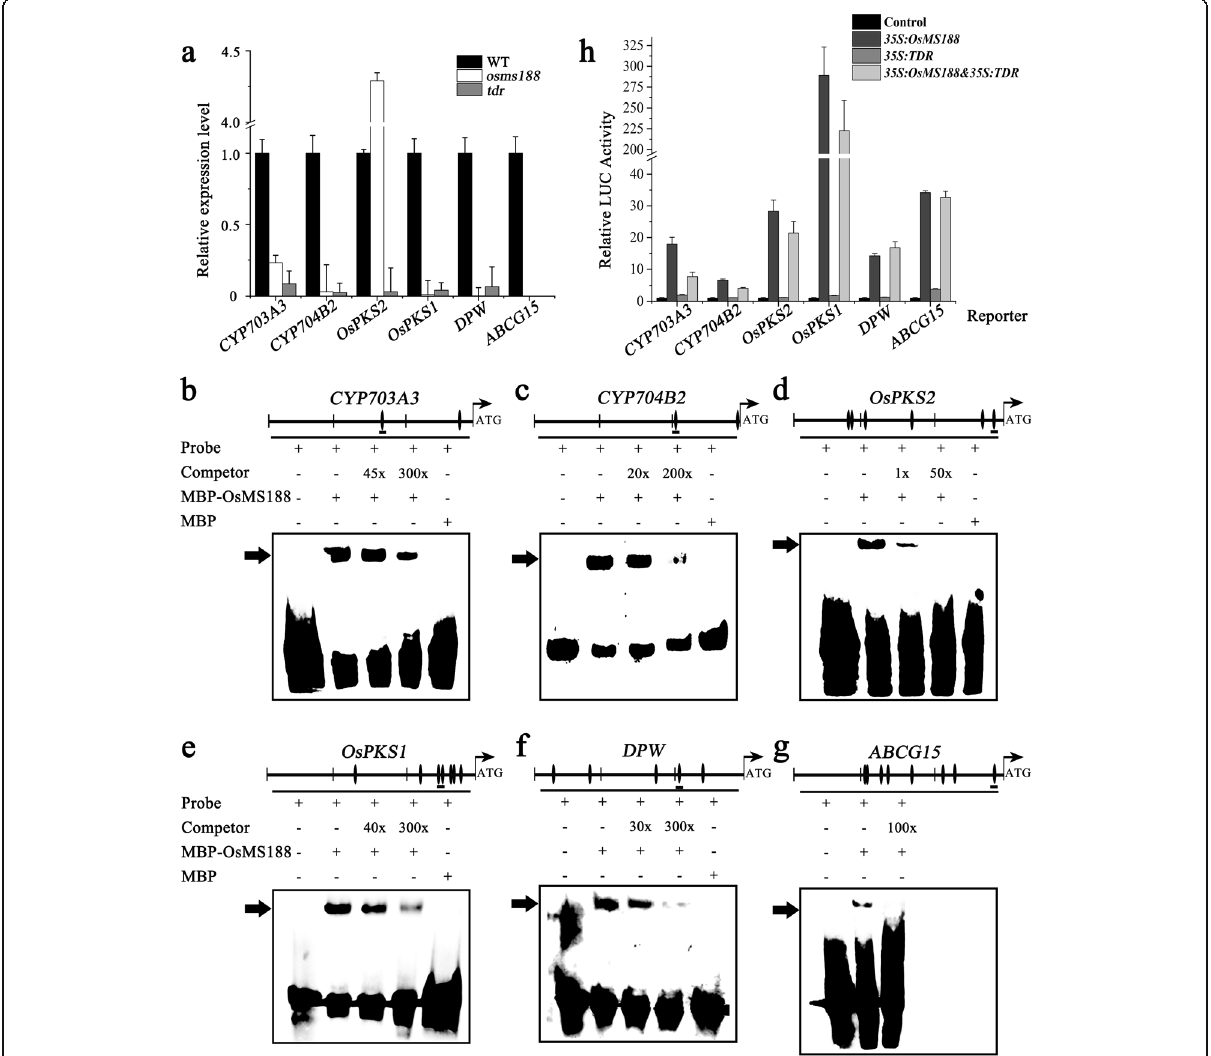
Fig. 7 OsMS188 directly regulates the expression of CYP703A3 , CYP704B2 , OsPKS2 , OsPKS1 , DPW and ABCG15 . a QRT-PCR analysis of CYP703A3 , CYP704B2 , OsPKS2 , OsPKS1 , DPW and ABCG15 expression in the inflorescences in WT, osms188 and tdr backgrounds. b - g EMSAs showing that OsMS188 can bind to the fragments of the CYP703A3, CYP704B2 , OsPKS2 , OsPKS1 , DPW and ABCG15 promoter regions. MBP-tagged proteins were mixed with a biotin-labelled probe, and unlabelled probes were used as competitors. The arrowhead indicates a shifted band. h Transient dual- luciferase assays were performed in Arabidopsis leaf protoplasts. A p35S::NOS vector was used as a negative control. p35s::OsMS188nos and p35s::TDRnos were transformed into protoplasts together with reporter plasmids. Three replicates were assessed, and the Y-axis shows the ratio of luciferase/Renilla. The errors bars indicate the